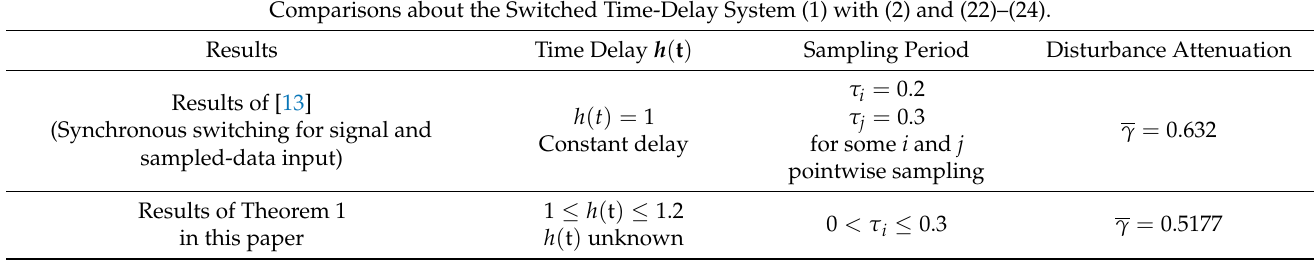
Table 4. Some comparisons of the sampled-data switched time-delay